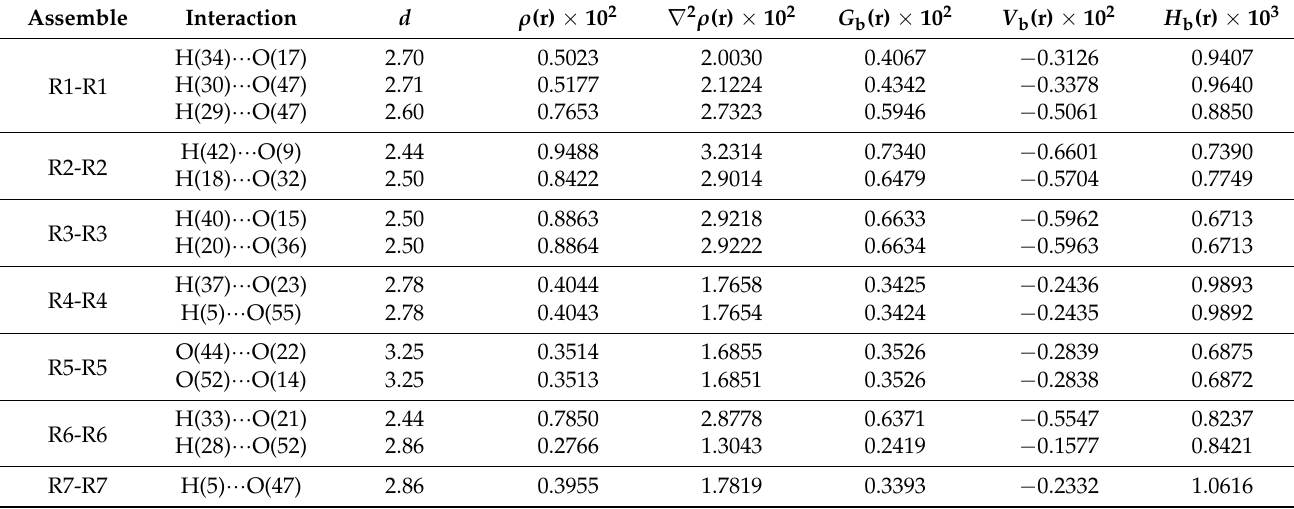
Table 2. Topological parameters of seven bimolecular assembles at the (3, − 1) critical points: calculated hydrogen bond length ( d ), electron densities ( ρ (r)), Laplacian of electron densities ( ∇ 2 ρ (r)), Laplacian of kinetic energy ( G b (r)), potential energy density ( V b (r)) and energy density ( H b (r)).